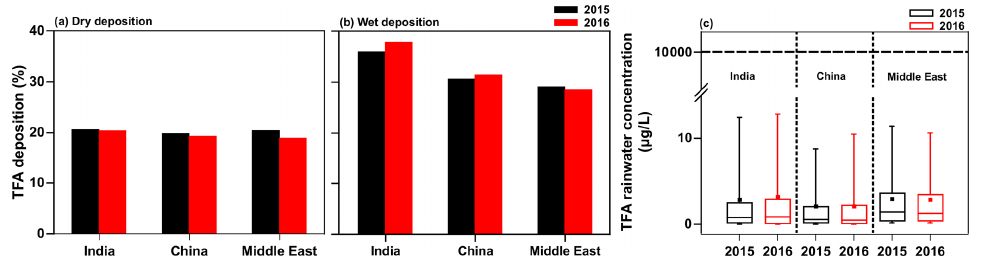
Figure 11. Annual percentage of total TFA (a) dry and (b) wet deposition and (c) annual mean TFA rainwater concentrations in India, China, and the Middle East domains from GEOS-Chem for 2015 and 2016. The dashed horizontal line is the NOEC level.